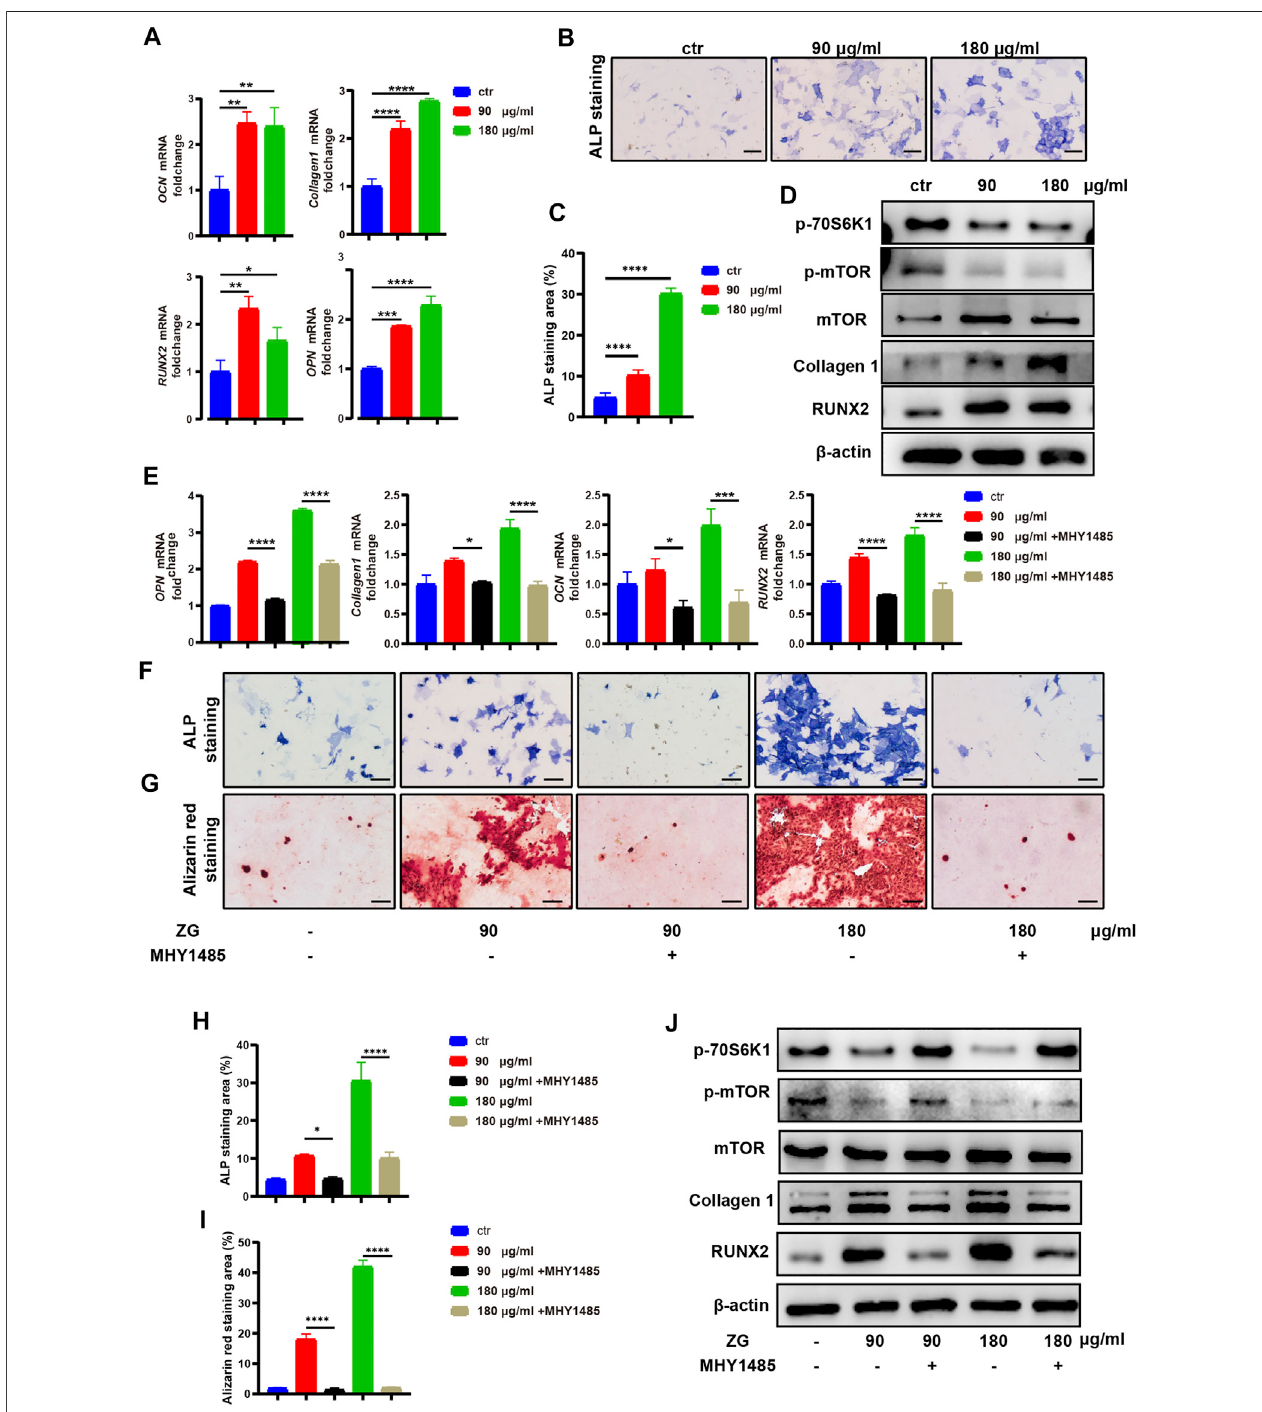
FIGURE4| ZGinhibitsthemTORC1/S6K1signalingpathwaytopromoteosteoblastdifferentiation invitro . (A) Q-PCRanalysisformRNAexpressionofosteogenic differentiationmarkergenesincludingosteocalcin(OCN),collagen1,RUNX2,andosteopontin(OPN)inpreosteoblasttreatedwithvehicle(ctr)andZGat90or180 μ g/ml concentration, respectively. (B) The representative images of ALP staining for preosteoblast at day 7 after treatment with vehicle (Ctrl) and ZG at 90 or 180 μ g/ml concentration, respectively. (C) Quanti fi cation forthepercentageofALP staining arearelative tototal areain indicated groups. (D) Western blot analysisfor protein levels of osteoblastic differentiation markers (collagen1, RUNX2, and β -actin) and mTORC1/S6K1 signaling pathway markers (p-70S6K1, p-mTOR, and mTOR) in preosteoblast treated with vehicle (ctr) and ZG at 90 or 180 μ g/ml concentration, respectively. (E) Q-PCR analysis for mRNA expression of osteogenic differentiation markergenes including OCN,collagen1,RUNX2,and OPN inpreosteoblasttreatedwithZG incombination withor withoutMHY1485. (F) The representative images of